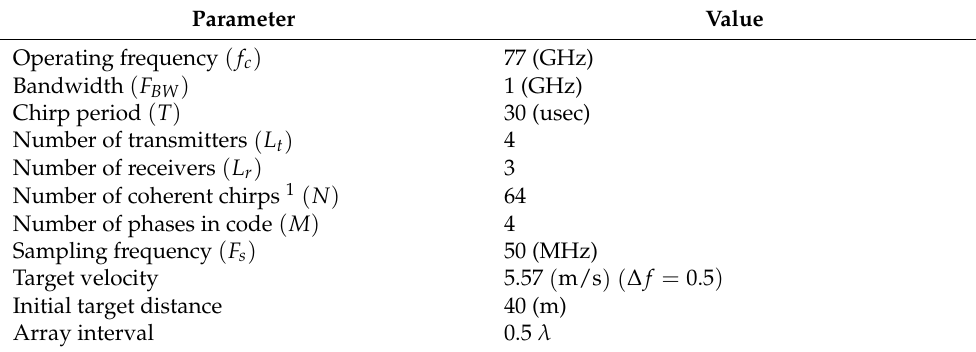
Table 2. Simulation parameters.